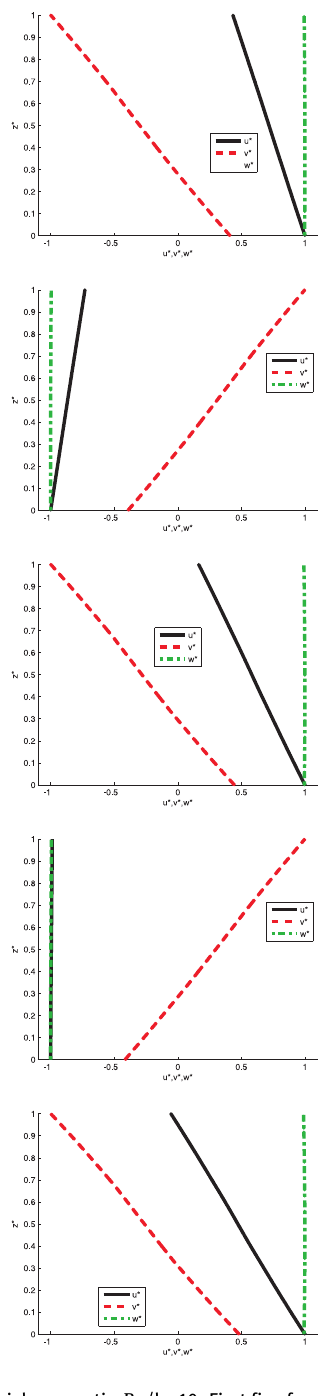
transverse anisotropy. The 3D element of Nastran could give better results but is is not used in this work because the main aim is the comparison between 3D exact models and 2D FE models. This 2D element of Nastran gives wrong